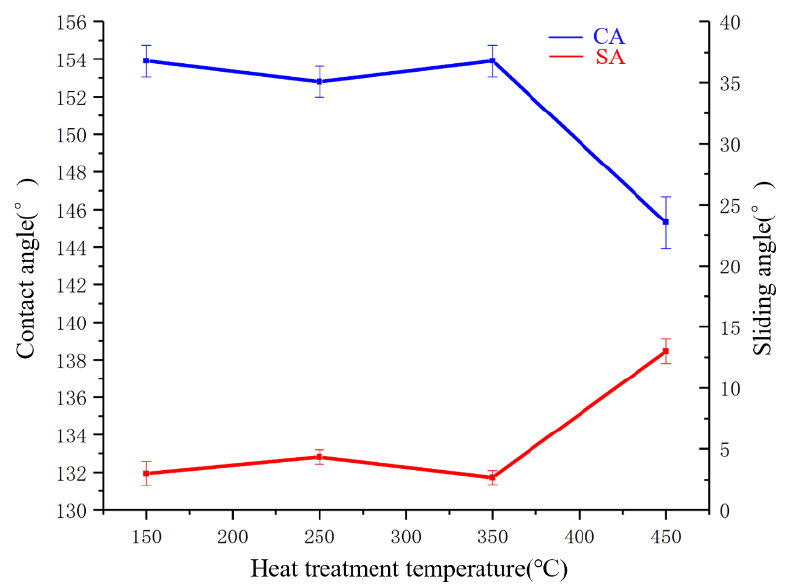
Figure 17. CA and SA at different heating temperature conditions.